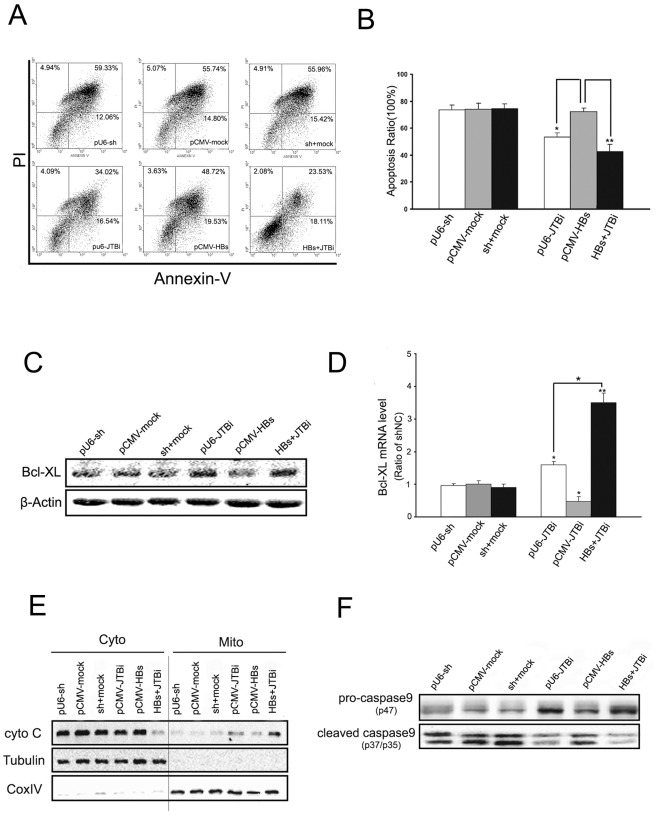
Stable knockdown of JTB in HCC cells decreases cell apoptosis.HepG2 cells were treated with 0.6 mM H2O2 for 8 h. (A) The percentage of apoptotic cells in HepG2 cells. (B) Quantification of apoptosis cells in different HepG2 cells. The percentage of apoptotic cells was determined using cyto-fluorimetric analysis with Annexin-V and PI labeling. The data were obtained from three analyses (*P<0.05). (C and D) The level of the Bcl-XL mRNA in HepG2 cells as measured using qRT-PCR. The results represent the mean of three amplifications and were calculated using the 2 exp(−△△Ct) formula. β-actin mRNA in HepG2 cells was used as a control (*P<0.05). (E) Western blot analysis of the cytosolic and mitochondrial cytochrome c levels in HepG2 cells induced by H2O2 after 8h. (F) Uncleaved (p47) and activated caspase-9 (p37) were detected by western blot analysis in HepG2 cells induced by H2O2 after 8 h.